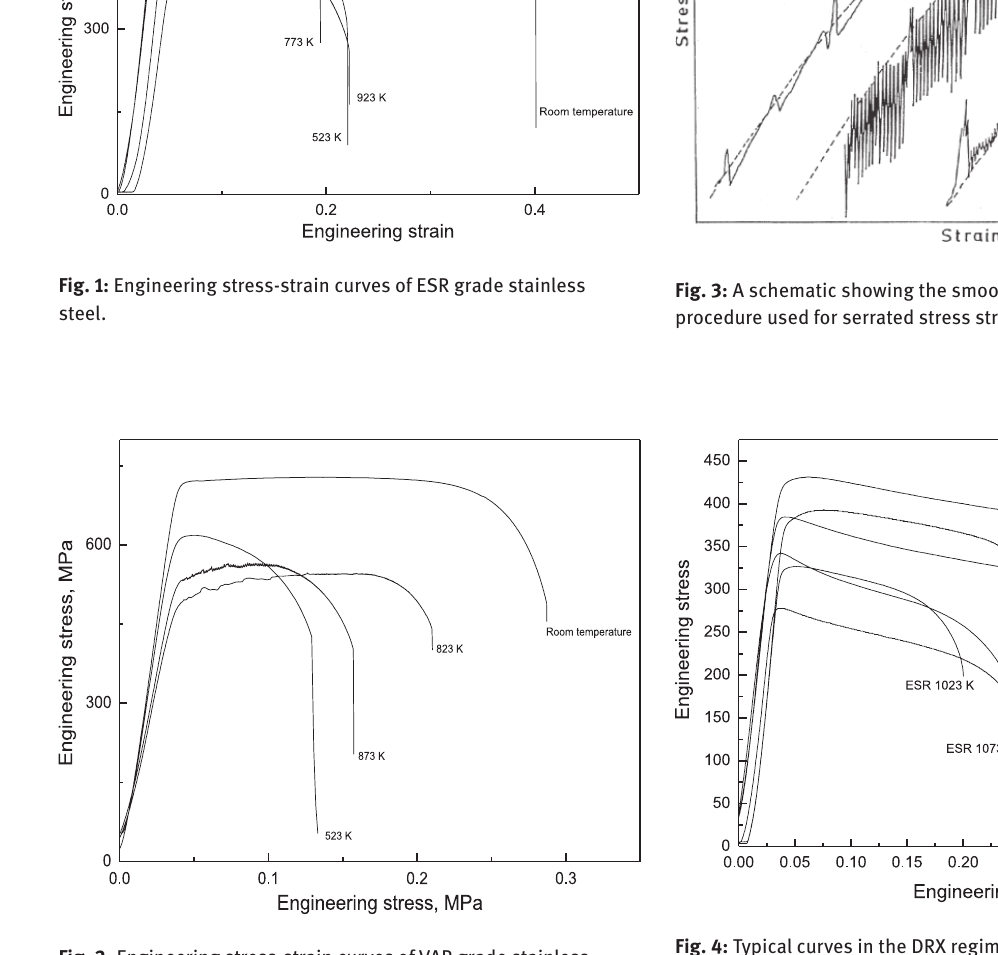
Fig. 2: Engineering stress-strain curves of VAR grade stainless steel.